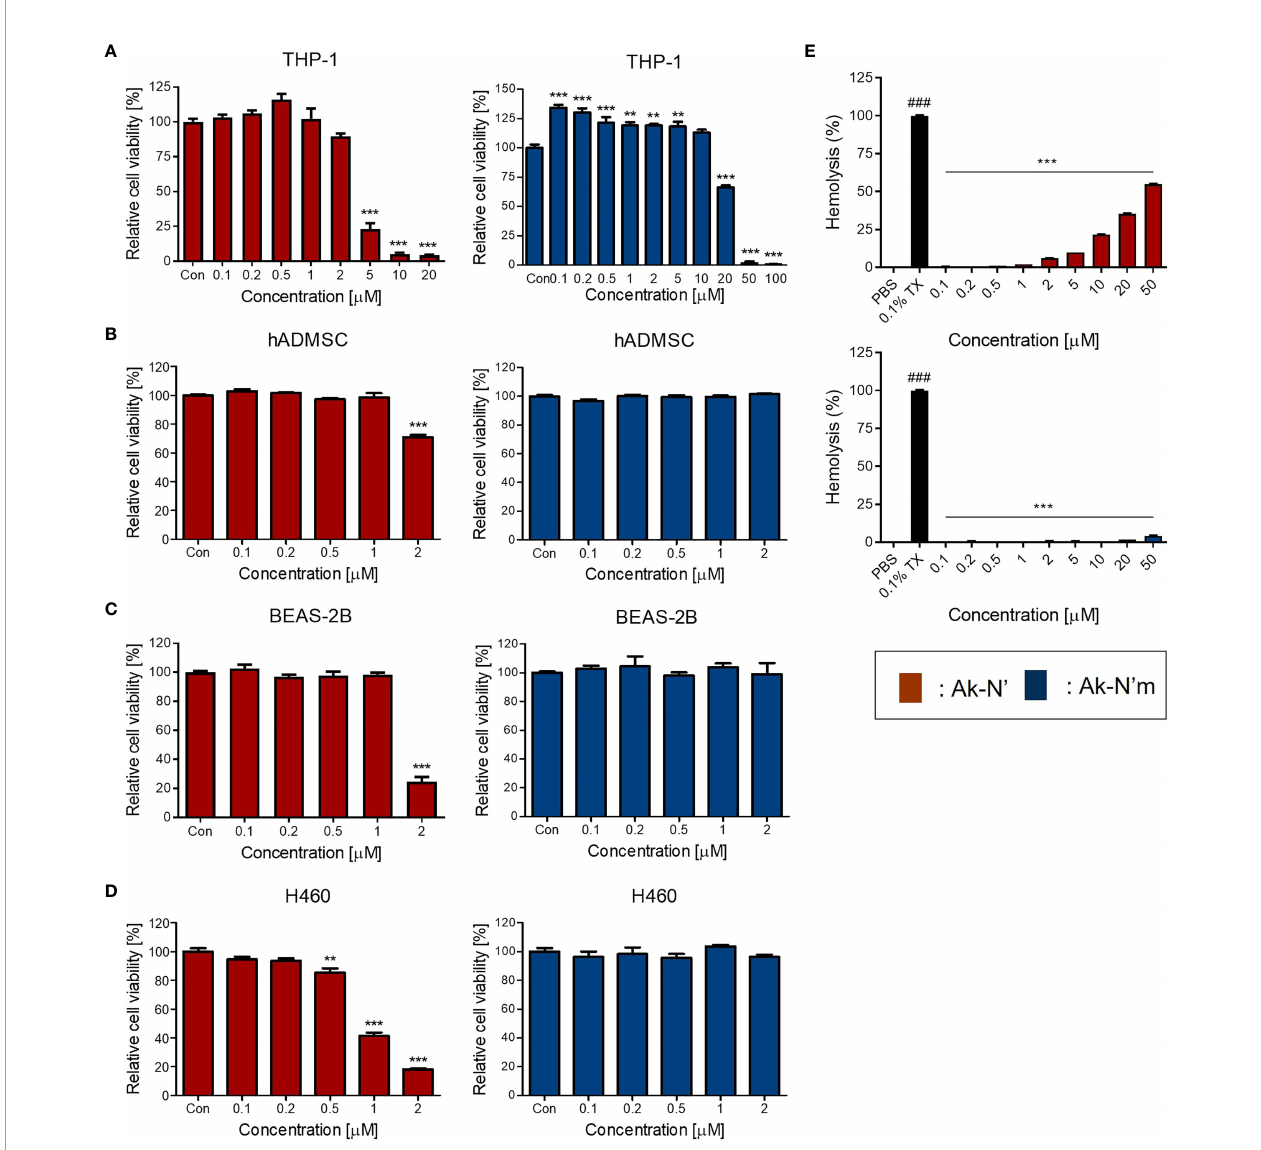
FIGURE 5 | Evaluation of cytotoxicity of the peptides on human cell lines and bovine red blood cells. Cell viability assay was conducted to evaluate the cytotoxic effect of peptides Ak-N ’ (red) and Ak-N ’ m (blue) using various concentrations. (A) THP-1, (B) hADMSC, (C) BEAS-2B, and (D) H460 cells were seeded at a density of 1×10 4 cells/well and WST-8 solution was used to measure the cell viability. (E) Hemolytic activity was evaluated using bovine RBCs by treating peptide ranging from 0.1 to 50 m M. Ak-N ’ showed hemolysis in a dose-dependent manner exceeding 50%, while Ak-N ’ m disrupted less than 5% of RBCs. Data are presented as mean ± SEM. **p < 0.01, and ***p < 0.001 compared to the control. ### p < 0.001 compared between the negative control (PBS) and the positive control (0.1% Triton